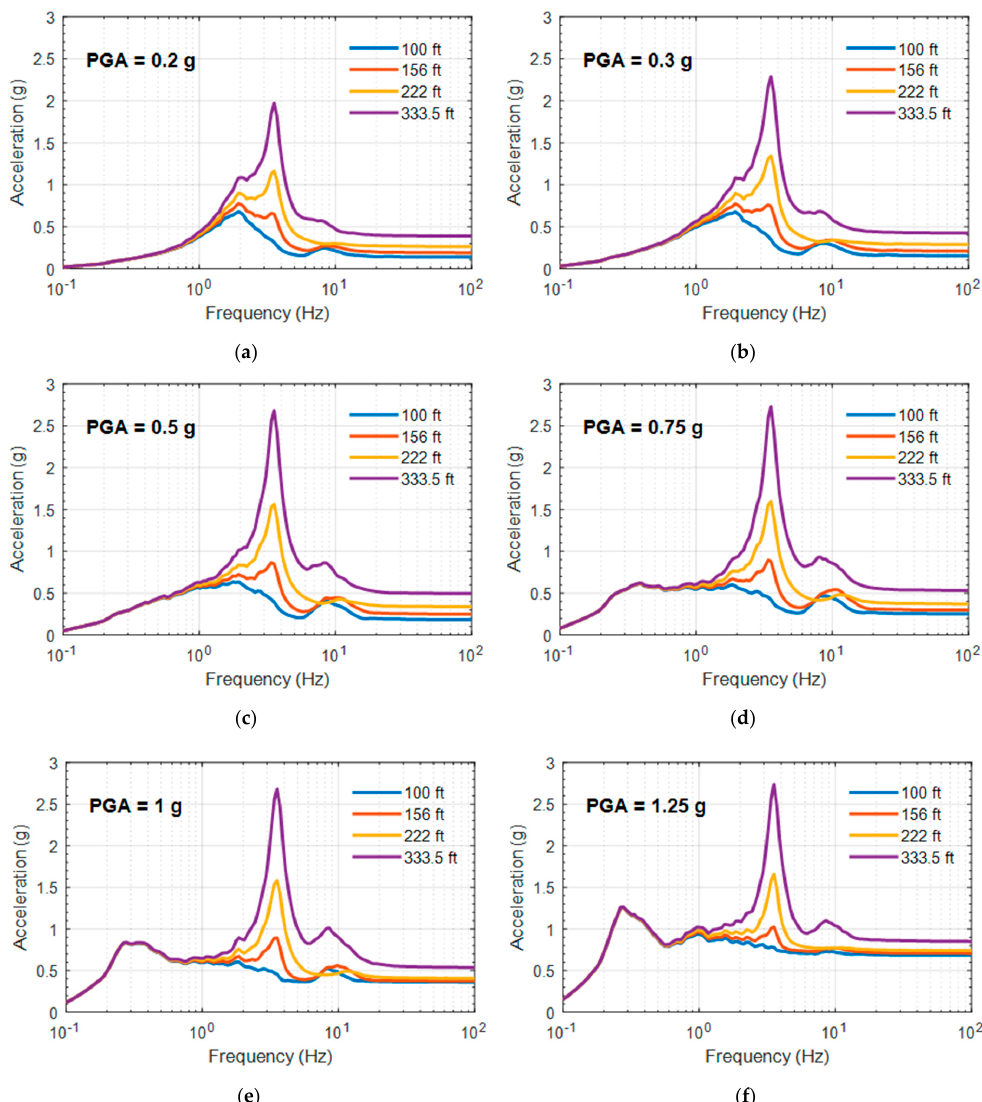
Figure 12. FRS of a base-isolated RCB at various PGA levels: ( a ) PGA = 0.2 g; ( b ) PGA = 0.3 g; ( c ) PGA = 0.5 g; ( d ) PGA = 0.75 g; ( e ) PGA = 1 g; ( f ) PGA = 1.25 g.